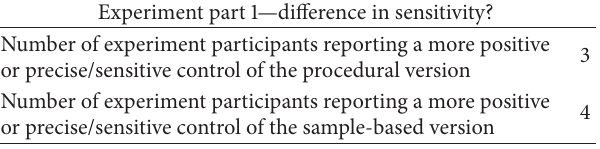
Table 10: Numbers of experiment participants that described